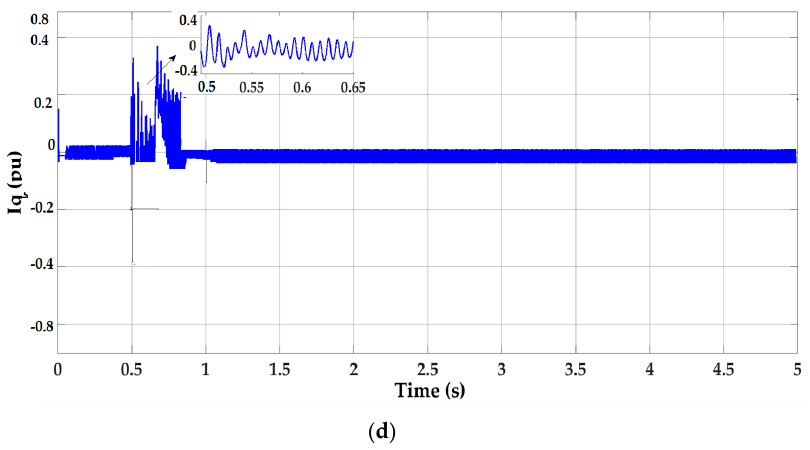
Figure 12. Simulation results of proposed control scheme under an asymmetrical fault (1LG). ( a ) DC-link voltage (DCL), ( b ) active power (P), ( c ) reactive power (Q), ( d ) reactive current (Iq).